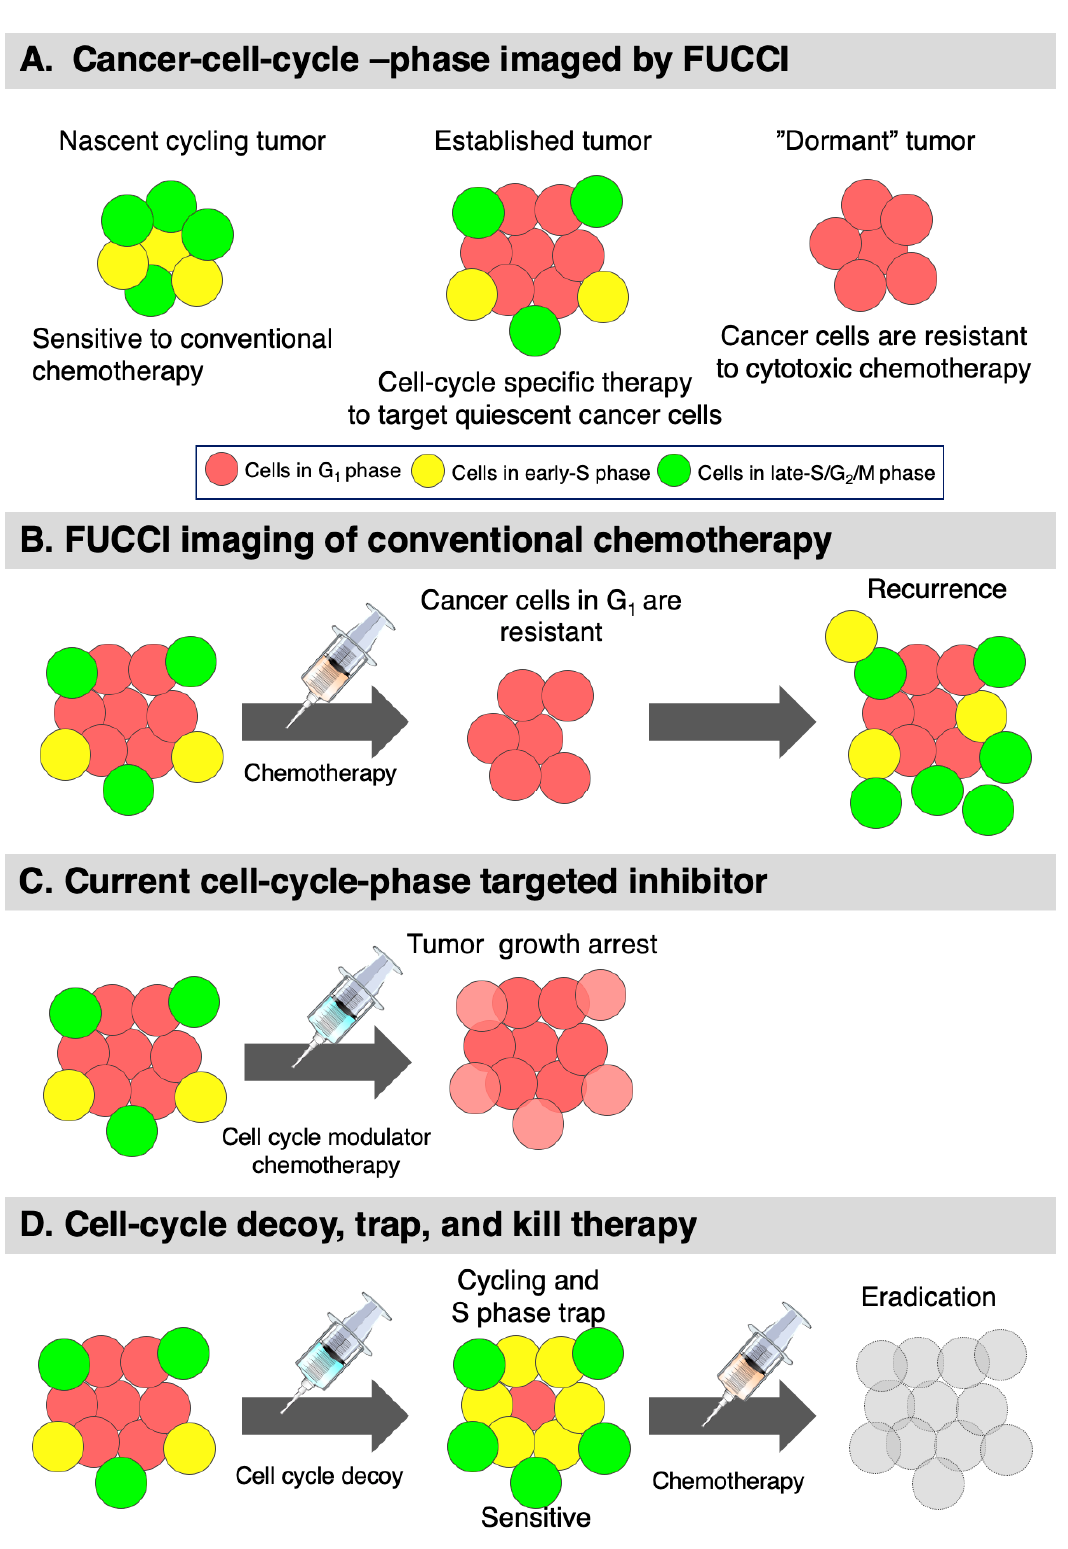
Figure 11. FUCCI image-guided cell-cycle targeted therapy. ( A ) FUCCI imaging of solid tumors at di ff erent stages: a nascent tumor comprising mostly cycling cancer cells, an established tumor consisting of mostly quiescent cancer cells, and some cycling cancer cells. A dormant tumor consisting of mostly quiescent cancer cells. ( B ) FUCCI imaging of chemotherapy of an established tumor. ( C ) FUCCI-guided cell-cycle-specific targeting with current inhibitors. ( D ) Cell-cycle decoy, trap, and kill chemotherapy.